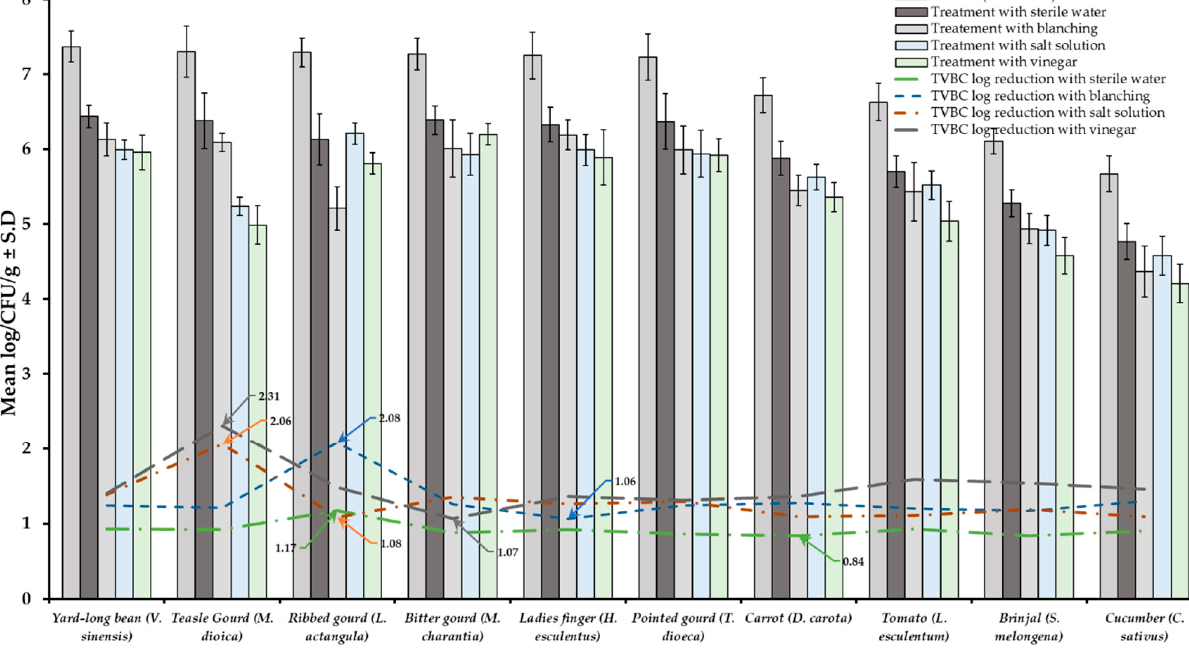
Figure 4. Four different treatments (sterile water, salt solution, blanched, and vinegar) were observed on total viable bacterial load (TVBC) decontamination from the surface of 10 different types of vegetables. Data are mean ( n = 4) ± standard deviation.